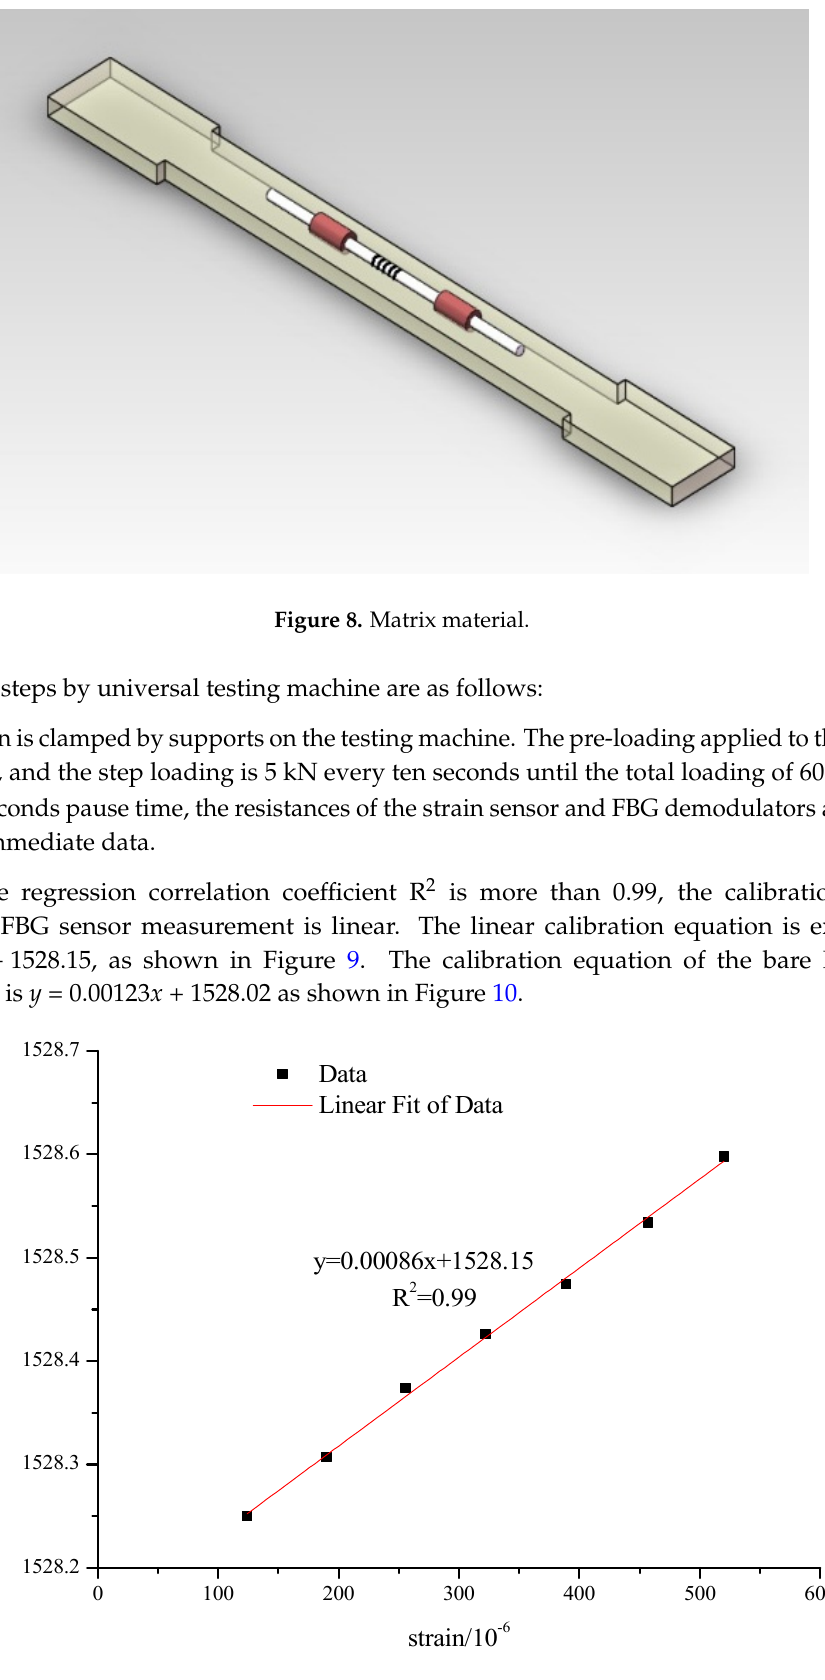
Figure 7. Bare FBG sensor.